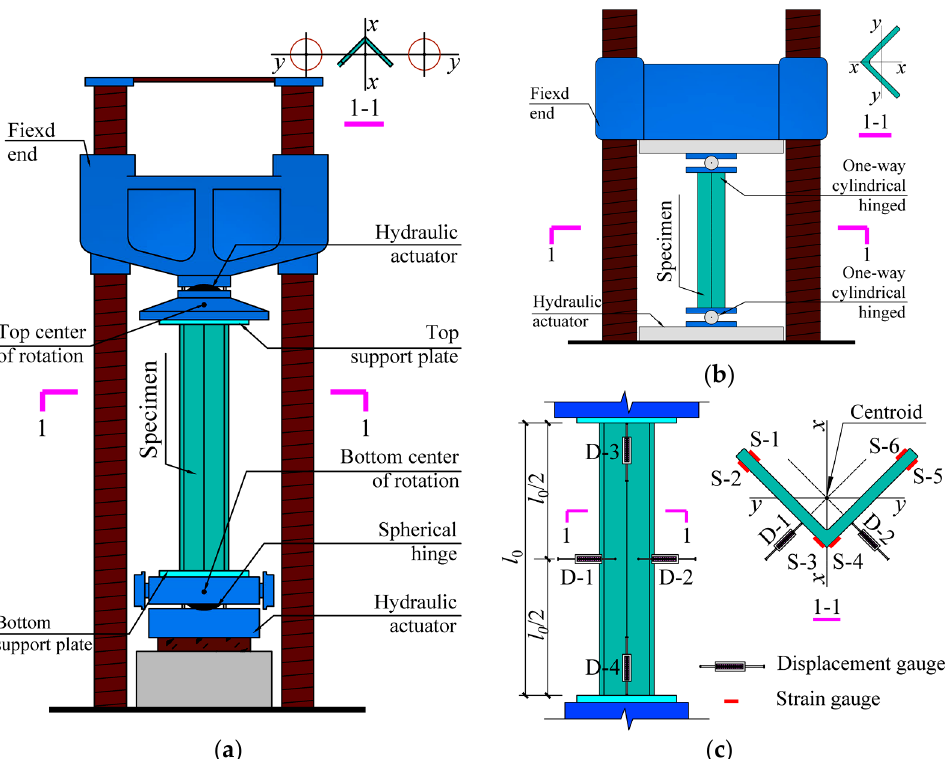
Figure 6. Test configuration: ( a ) 500 t illustration; ( b ) 3000 t illustration; ( c ) measurement illustration. Table 4. Step load